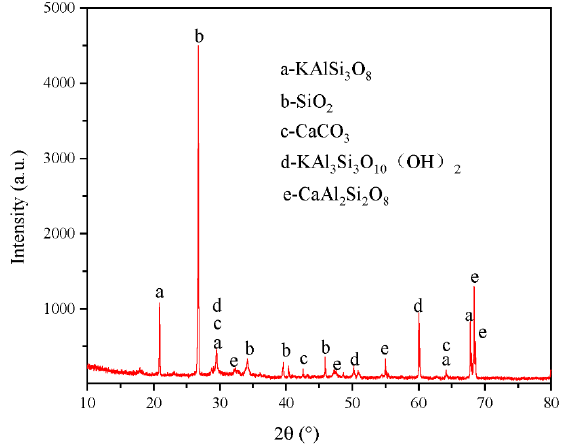
Figure 4. X-diffraction of the rock-like sample.